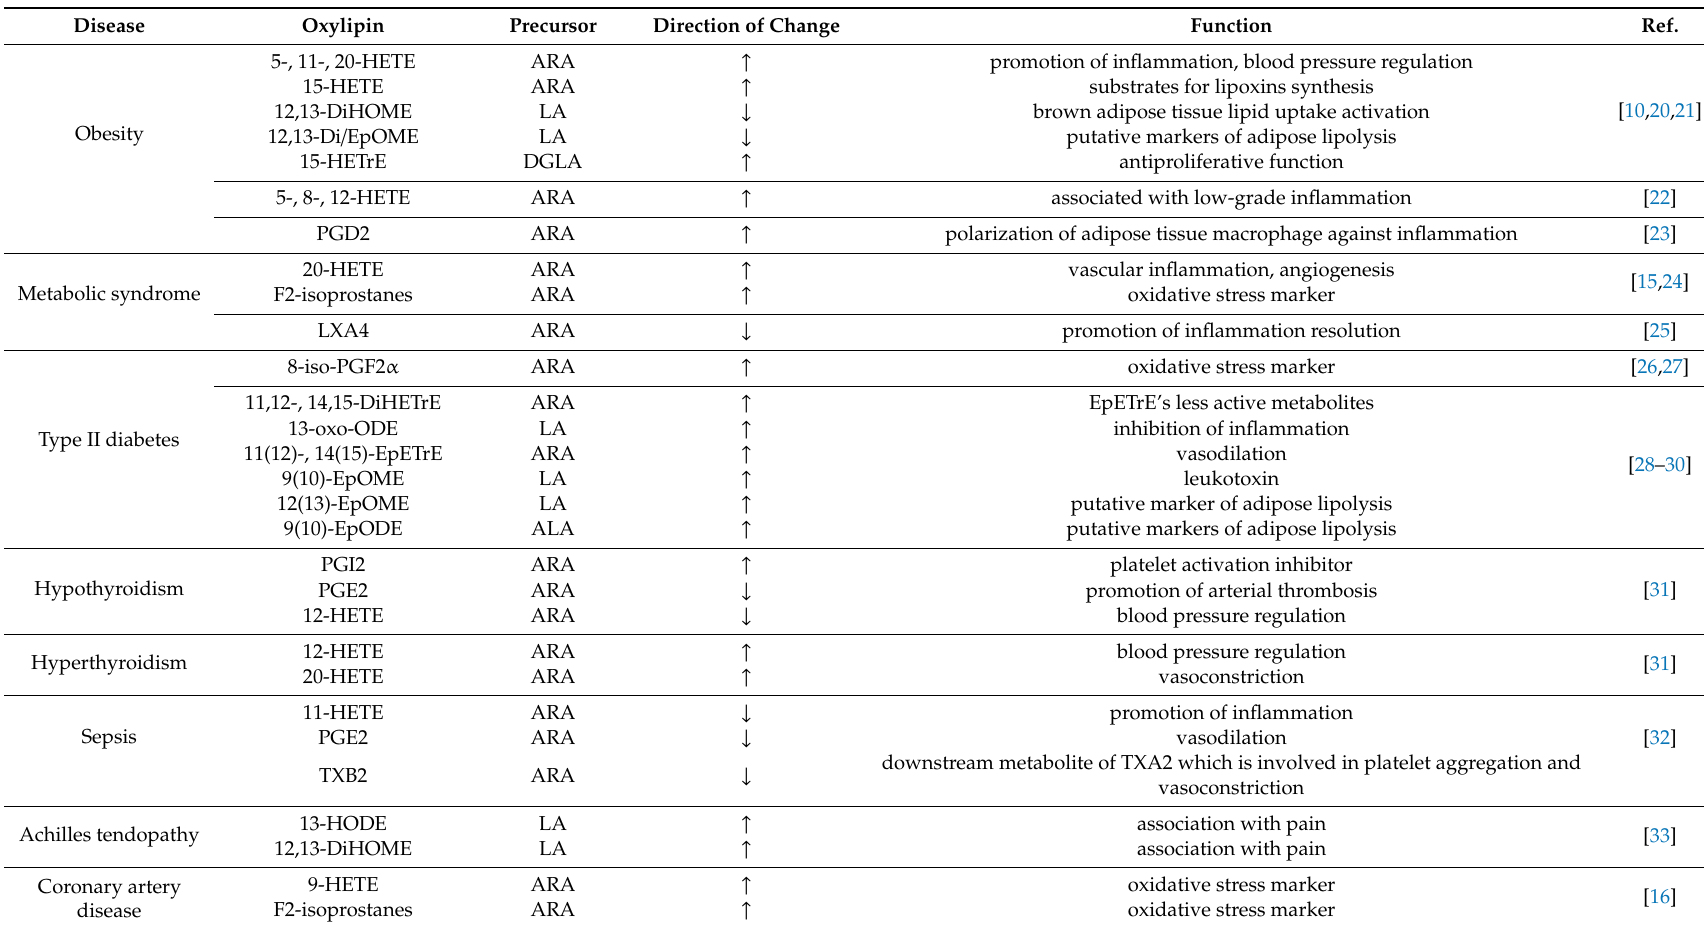
Table 1. Selected oxylipins and their physiopathological functions in human